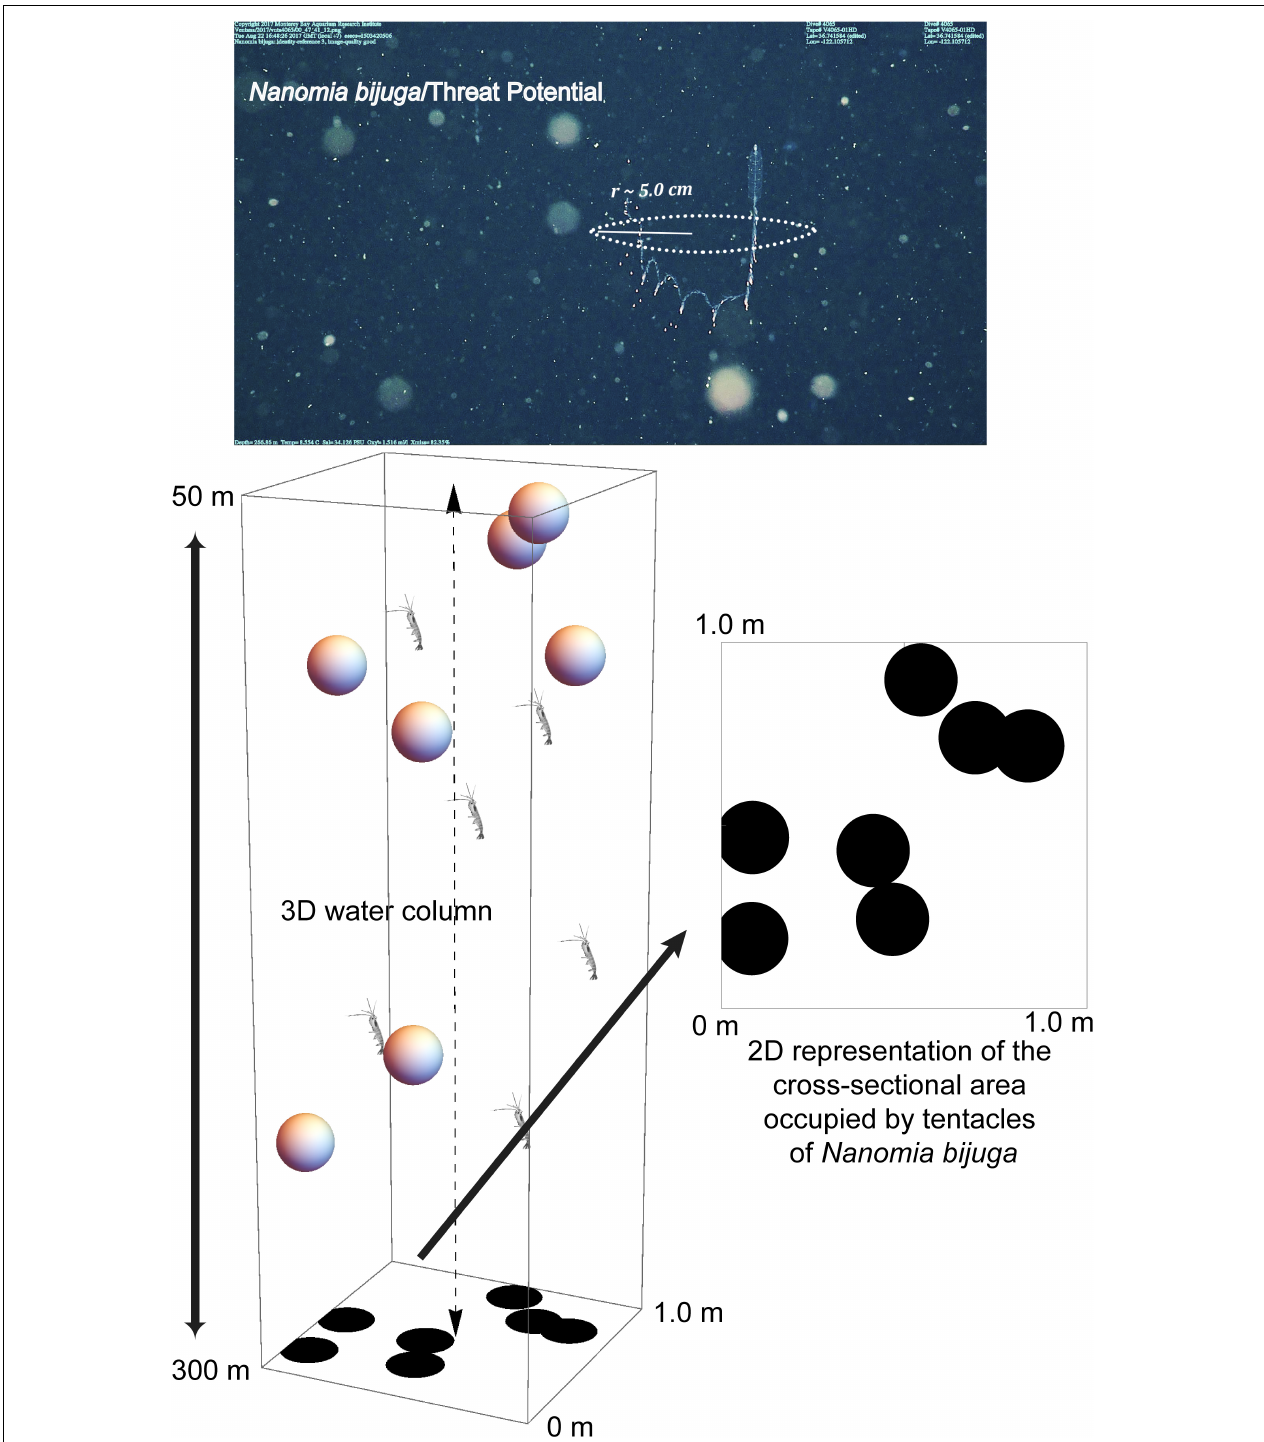
FIGURE 1 | ROV video frame grab of the physonect siphonophore, Nanomia bijuga , fishing with its siphosome forming a “J” shape and tentilla with nematocysts (stinging cells) emanating outward and around the animal. A radius of 5 cm constitutes an average threat potential of ∼ 4–8% for the siphonophore, depending on seasonal abundance. The 3D diagram illustrates N. bijuga (spheres) in the 1 m 2 × 250 m water column through which the vertically migrating prey (euphausiids) traverse. The threat potential was calculated based on the space occupied by the predator’s tentacles (dark circles) versus unoccupied space in the 2D illustration. Not to